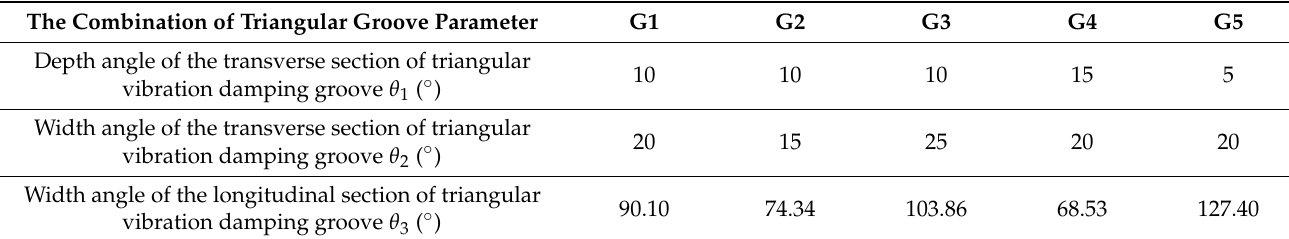
Table 4. Parameters related to